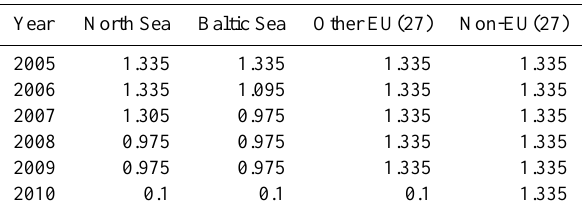
Table 2. Sulfur content assumed in the fuel for the calculation of in-port emissions (in